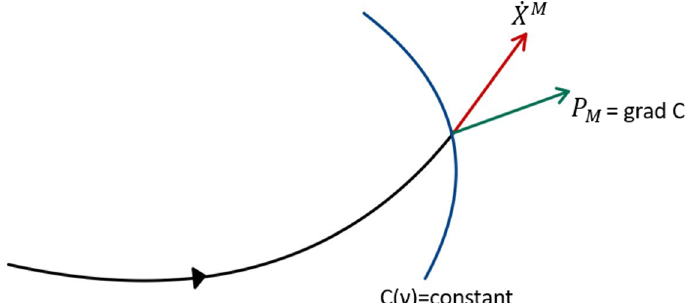
Figure 3 . The red arrow represents the direction of motion of a particle in the auxiliary system (tangent to the trajectory γ ( t ) ), the green arrow represents the direction of the particle’s momentum (perpendicular to the blue curve), and the blue curve represents a surface of equal